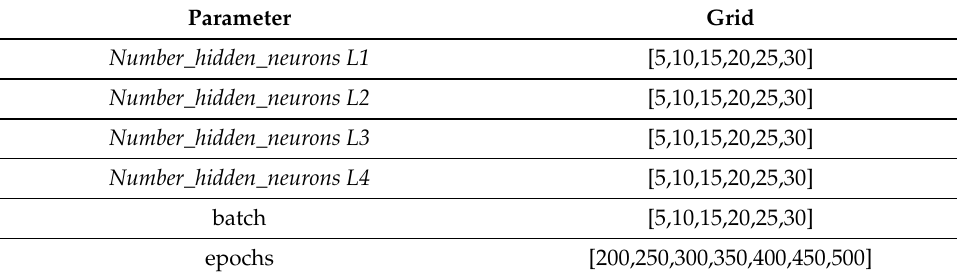
Table 2. Grid parameters of